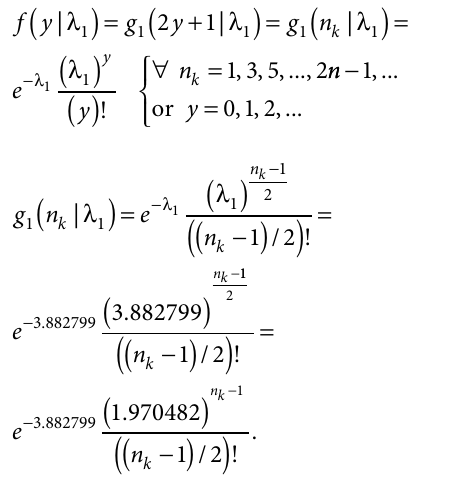
Fig. 3. The frequency of the distribution of household trip production in